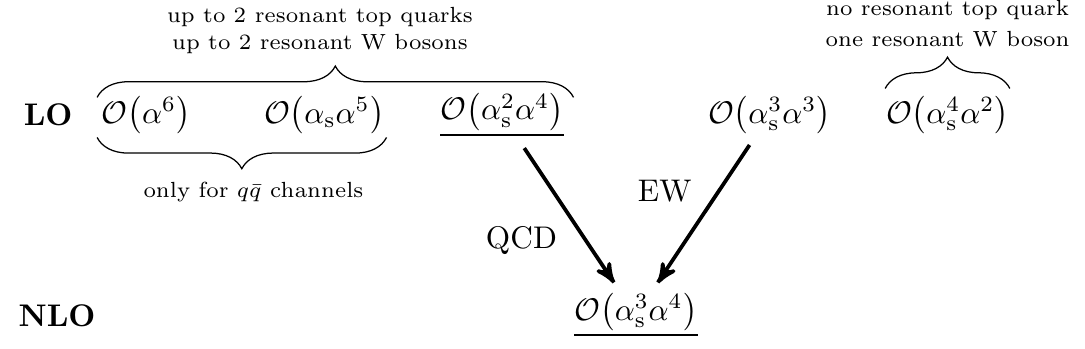
Figure 1. Graphical representation of contributions to the cross section of pp NLO, the order receives QCD corrections and EW correction to the orders O are the ones considered in the present calculation.